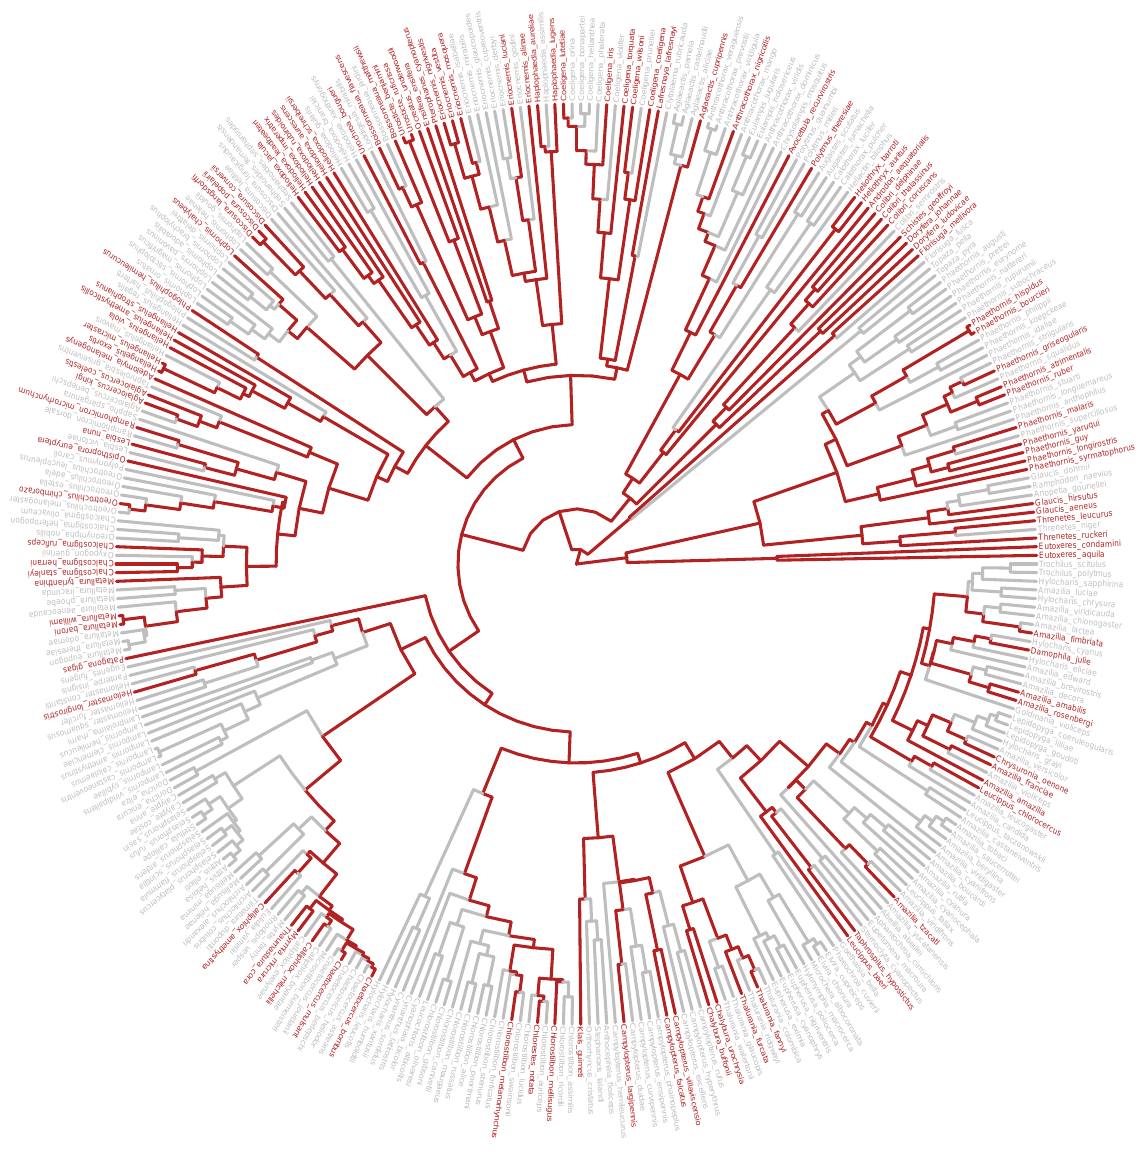
Supplementary figure 2 – Phylogenetic coverage of the Trochilidae family in our dataset (species and lineages in